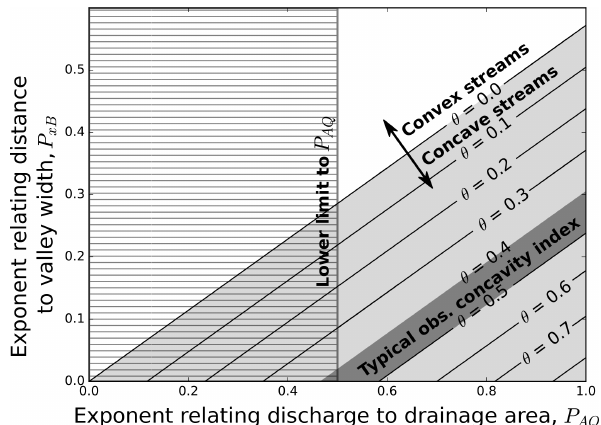
Figure 4. The slope–area concavity index defined in Eqs. (51) and (54) limits the range of possible powers for discharge–drainage area and width–distance relationships. The light gray field includes all concave long profile solutions, and the dark gray area indicates where the concavity index is in a commonly observed range for rivers in the field, between 0.4 and 0.5. The hatched area on the left is below the theoretical lower limit for the exponent that relates drainage area to water discharge, P A,Q = 0 . 5, which exists in the limit where storm duration is much less than the time taken for water to pass through the catchment (Sólyom and Tucker, 2004). This ex- ample is given for an equilibrium-width river for which d z/ d t = U , which corresponds to the analytically solvable case in Eqs. (39) and